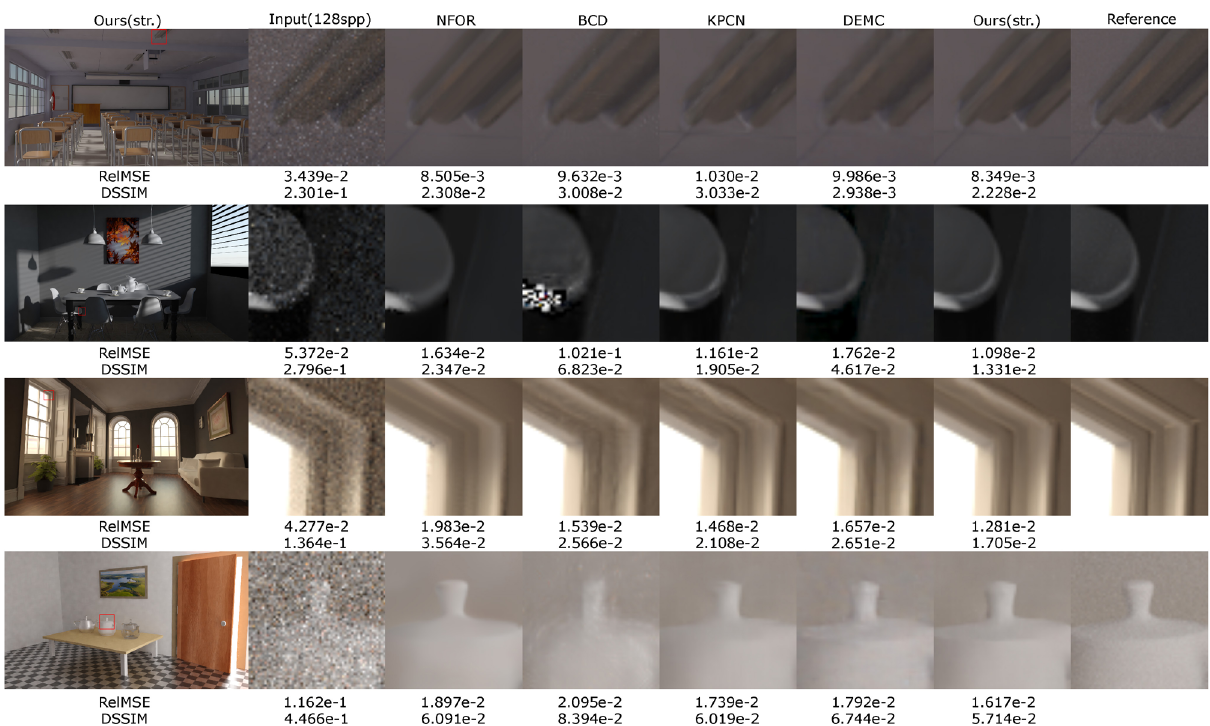
Fig. 7 Network structure comparison between our model (str. means network structure only) and previous works. To validate the effect of network structure, our network training does not use light transport covariance and perceptual loss. KPCN, DEMC, and our method have the same training settings (see Section 5.2) other than the network structure. Even without light transport covariance and perceptual loss, our method provides a better result.